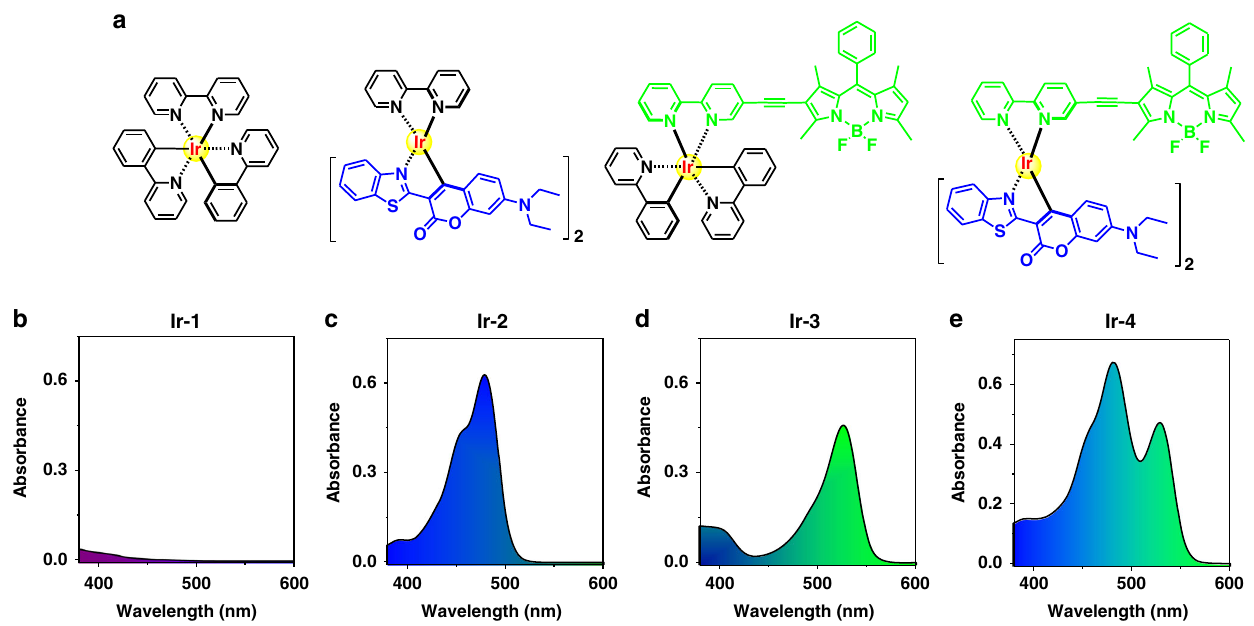
Fig. 1 Molecular structures and absorption spectra of photosensitizers. a Molecular structures and ultraviolet − visible absorption spectra of b Ir-1 , c Ir-2 , d Ir-3 , and e Ir-4 in CH 3 CN (5 μ M)